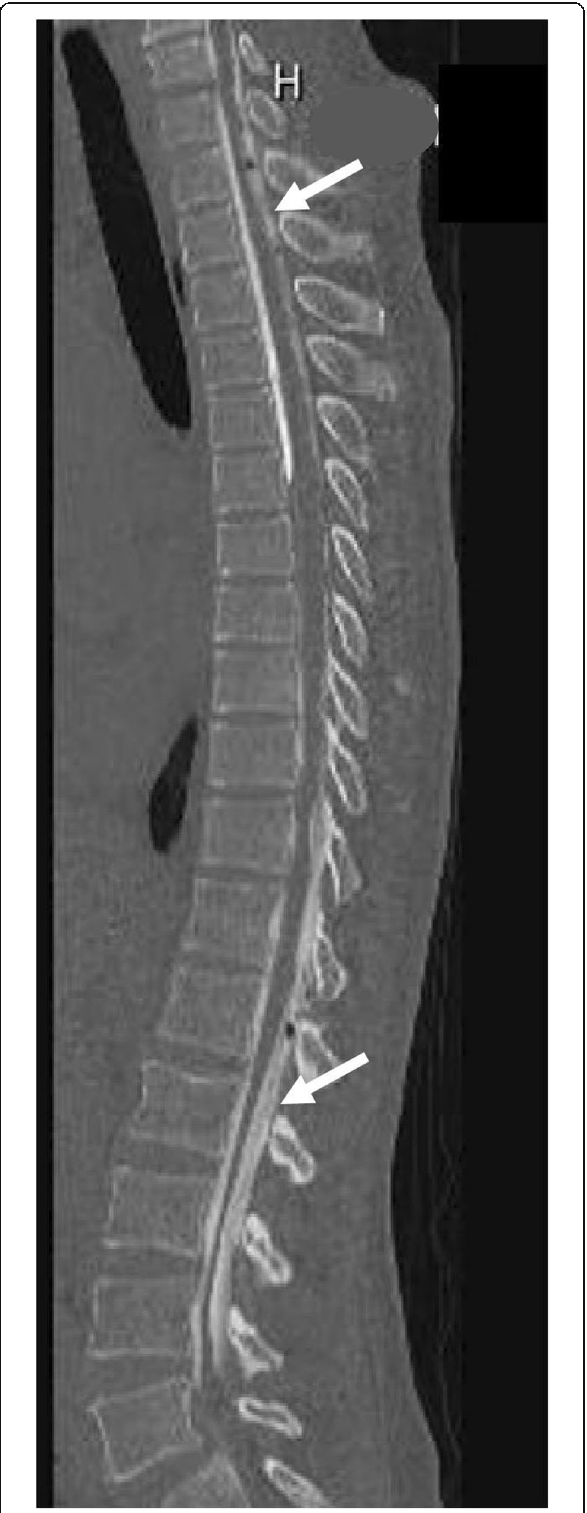
Fig. 3 Sagittal cervicothoracic spinal MRI showing hyperintense epidural fluid collection (arrows) indicating sealing of the leakage site. MRI, magnetic resonance